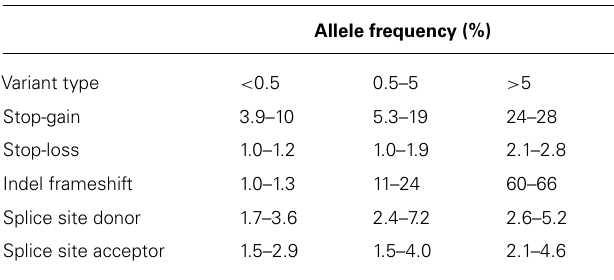
Table 1 | Loss of function allele counts in 1,092 human genomes across three allele frequency